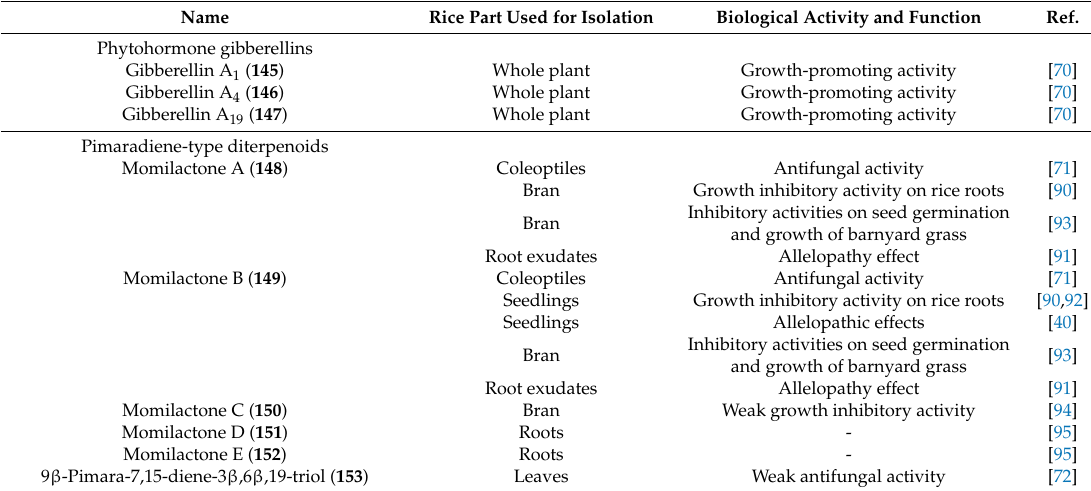
Table 5. Diterpenoids and their biological